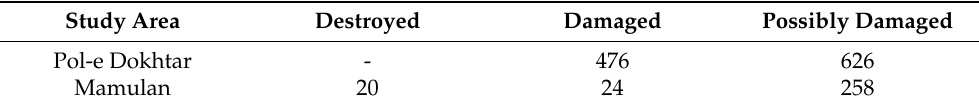
Table 6. The number of affected buildings/properties in Mamulan and Pol-e Dokhtar by the flood event in.